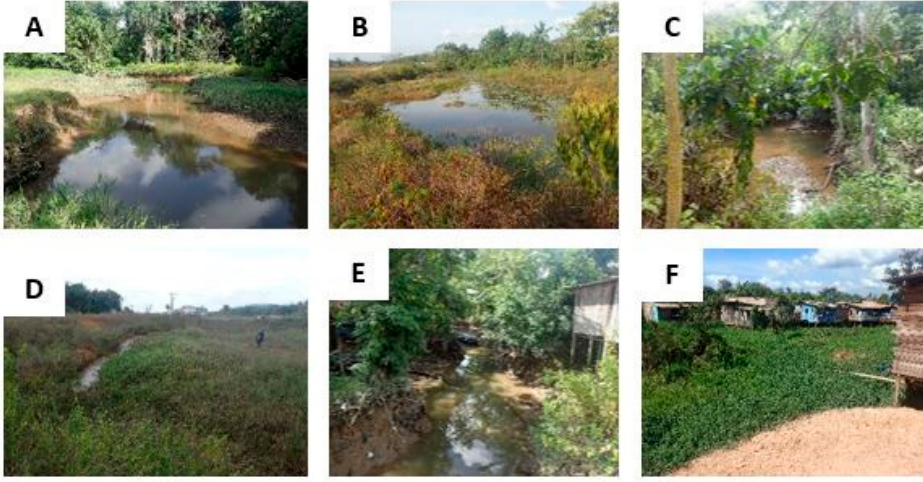
Figure 9. Various types of vegetated wetlands encountered in the Amazon region, more specifically in a peri ‐ urban area. ( A ) = riverbed with vegetated edges; ( B ) = heterogeneous vegetation at the surface of a pond; ( C ) = roadside muddy ditch; ( D ) = roadside ditch composed of stagnant water; ( E ) = riverbed where freshwater and used water are mixed; and ( F ) = strongly vegetated swamps surrounded by wooden houses on stilts.